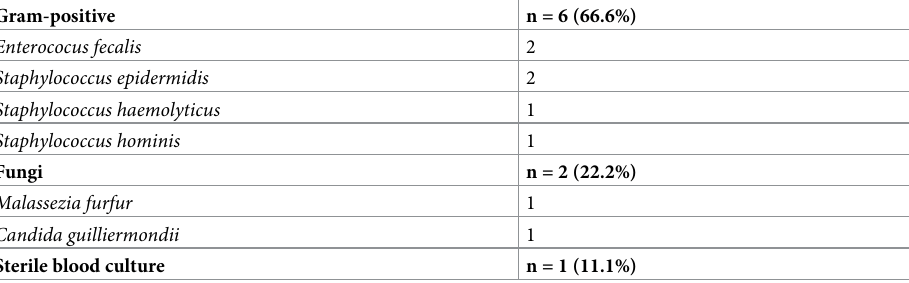
Table 4. Microorganisms isolation in TCVC-related infections (total n = 9).